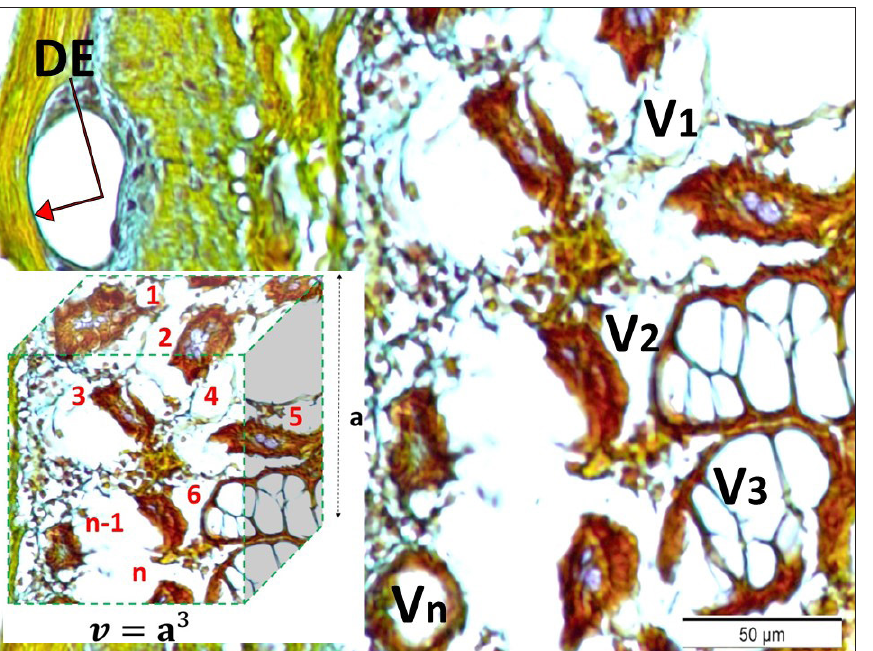
Figure 8. Histological view of the dilated intestinal artery with degenerated endothel (DE) and atrophic villi (LM, Aldehyde Fuchsin, x2/A), degenerated villi, and paramount vacuoles (V1-n) (LM, Aldehyde Fuchsin, x4/Base) of a study animal. In the intestines considered to be cylinders, the number of vacuoles per cubic millimeter is determined by dividing the wall surface volume by vacuole volume Blood pH regulating paraganglia ischemia- induced acidosis is probably the most for- gotten cause of intestinal ischemia and even necrosis.